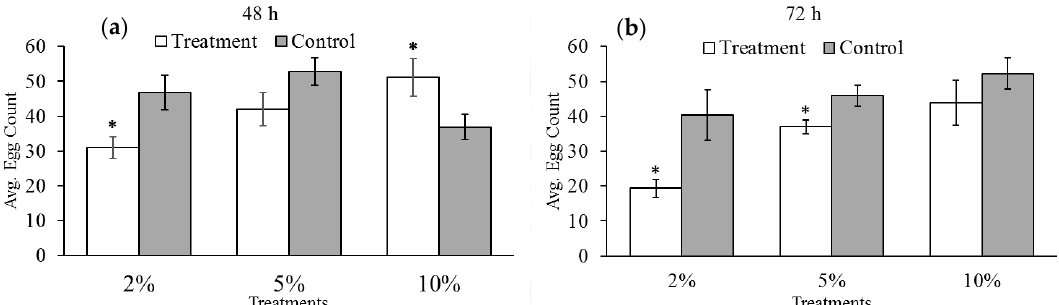
Figure 2. Average number of eggs laid by female cowpea bruchids over their lifetimes both during and following exposure to ( a ) 48 and ( b ) 72 h of exposure to hypoxia. Asterisks represent statistically significant differences between oxygen treatment groups (white) and paired control groups (gray). Bars with no asterisk were not significantly different from the control group. We observed negative effects of our treatment oxygen levels on the reproductive output of female bruchids relative to our control groups.